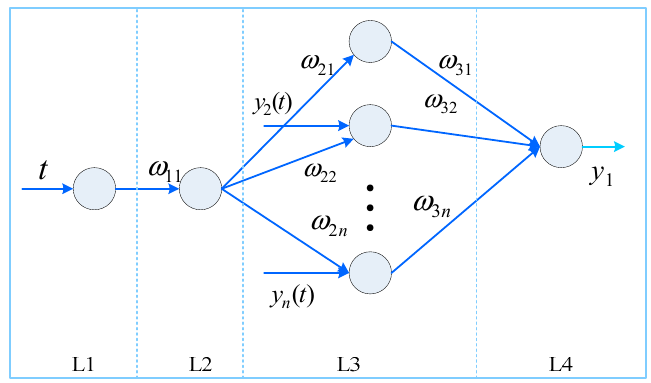
Figure 2. The topology of GNN model.